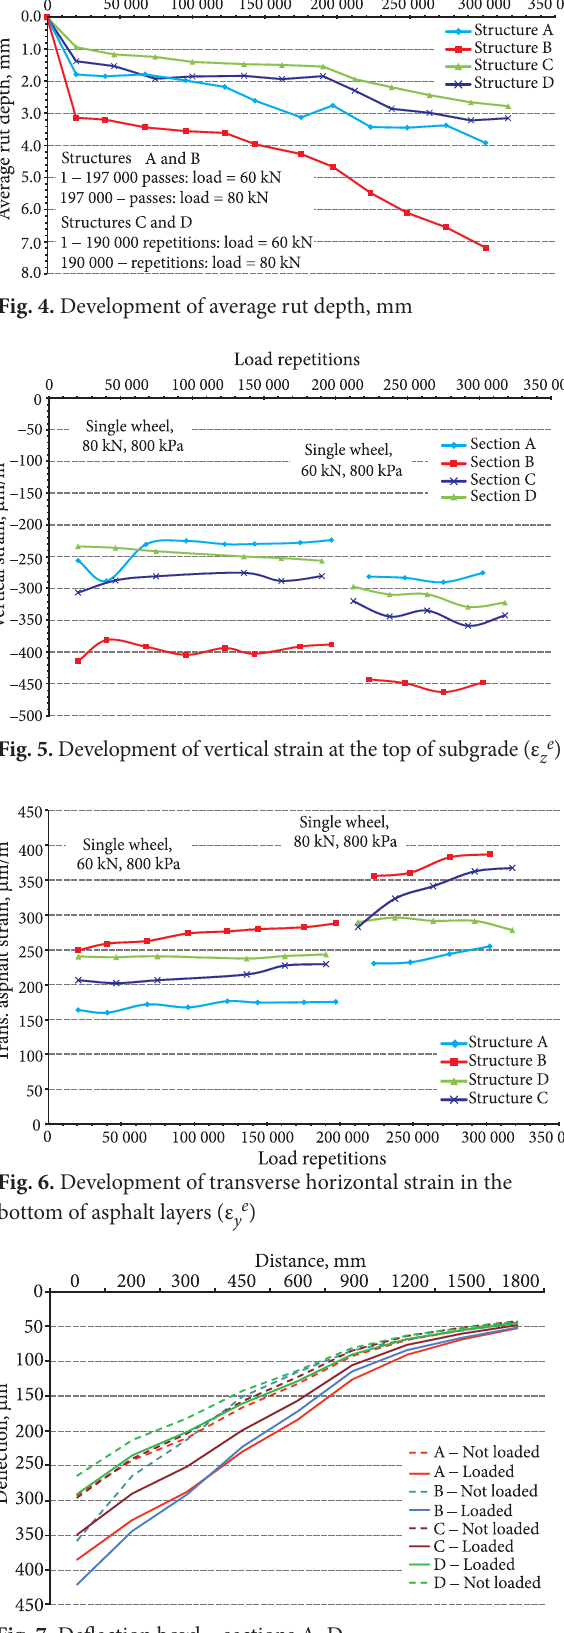
Fig. 7. Deflection bowl – sections